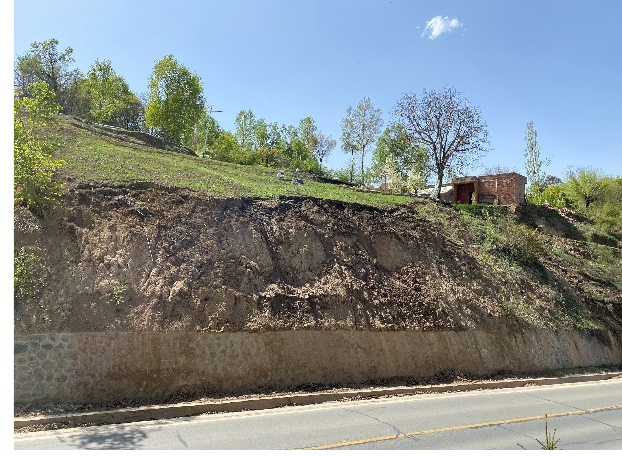
Figure 21. Photos of Lashagou NO.3 landslide.